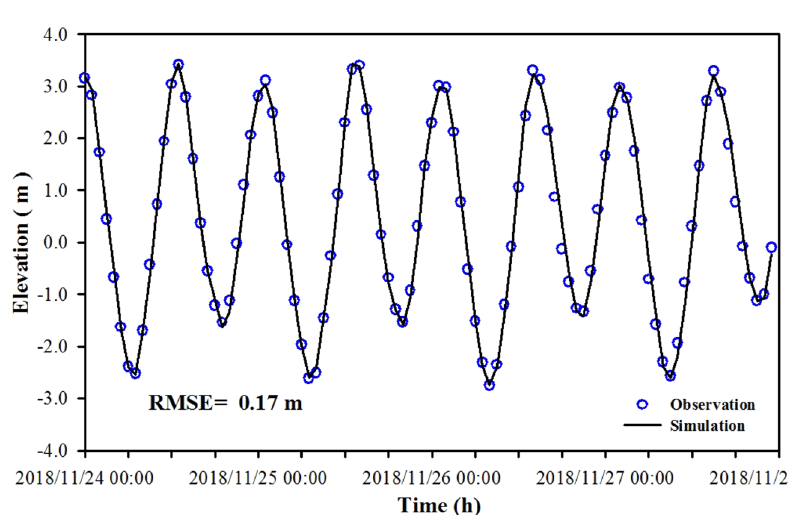
Figure 3. Comparison between the observation and simulation of tidal elevation versus time. The figure was drawn with SigmaPlot Version